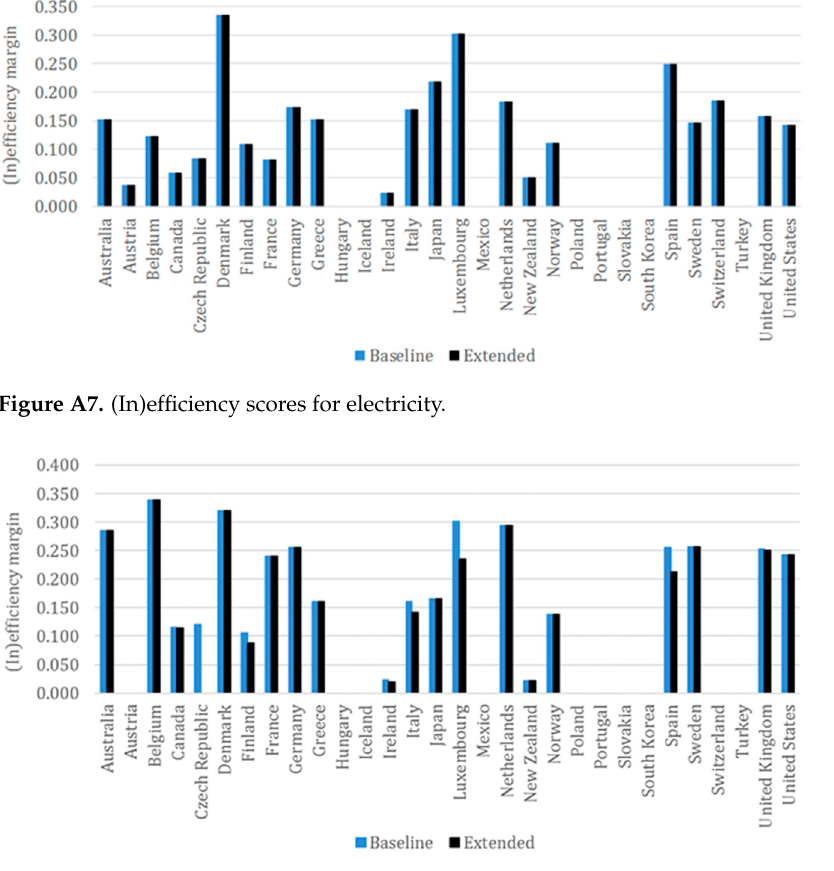
Figure A8. (In)efficiency scores for electricity with renewable electricity capacity.